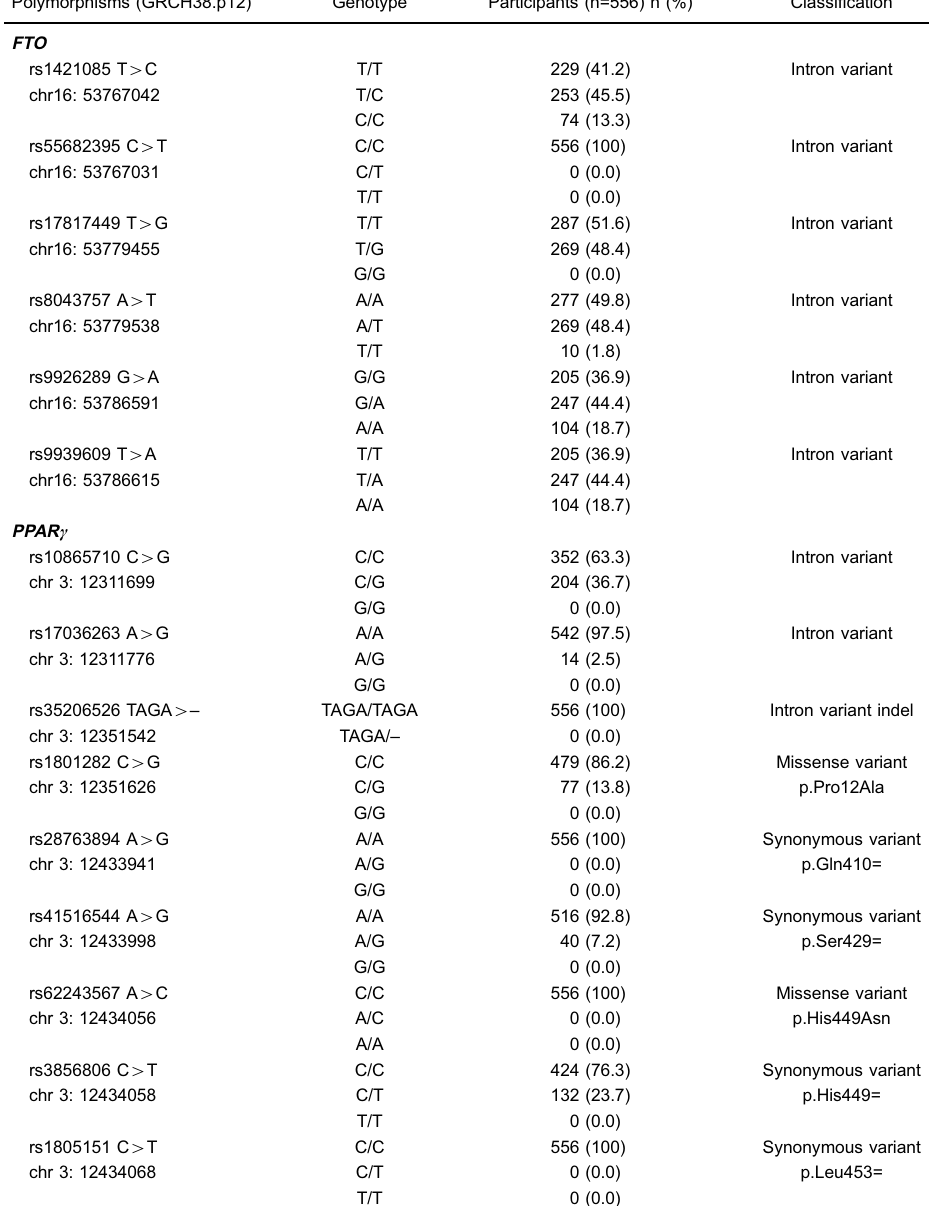
Table 1. Genotype frequencies and classi fi cation of single-nucleotide polymorphisms (SNPs) of the FTO (fat mass and obesity-associated) and PPAR g (peroxisome proliferator-activated receptor-gamma) genes. Polymorphisms (GRCH38.p12)